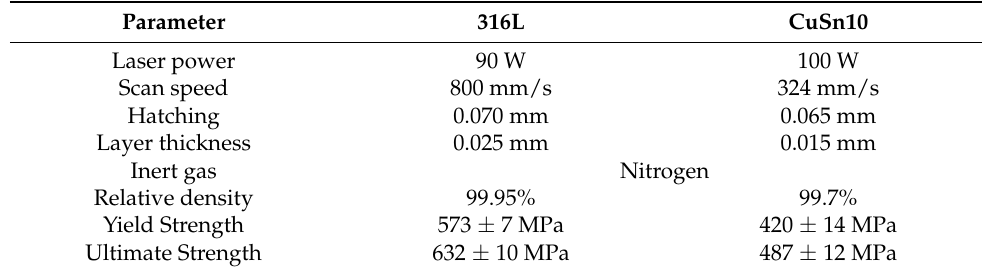
Table 1. Parameters used for manufacturing the